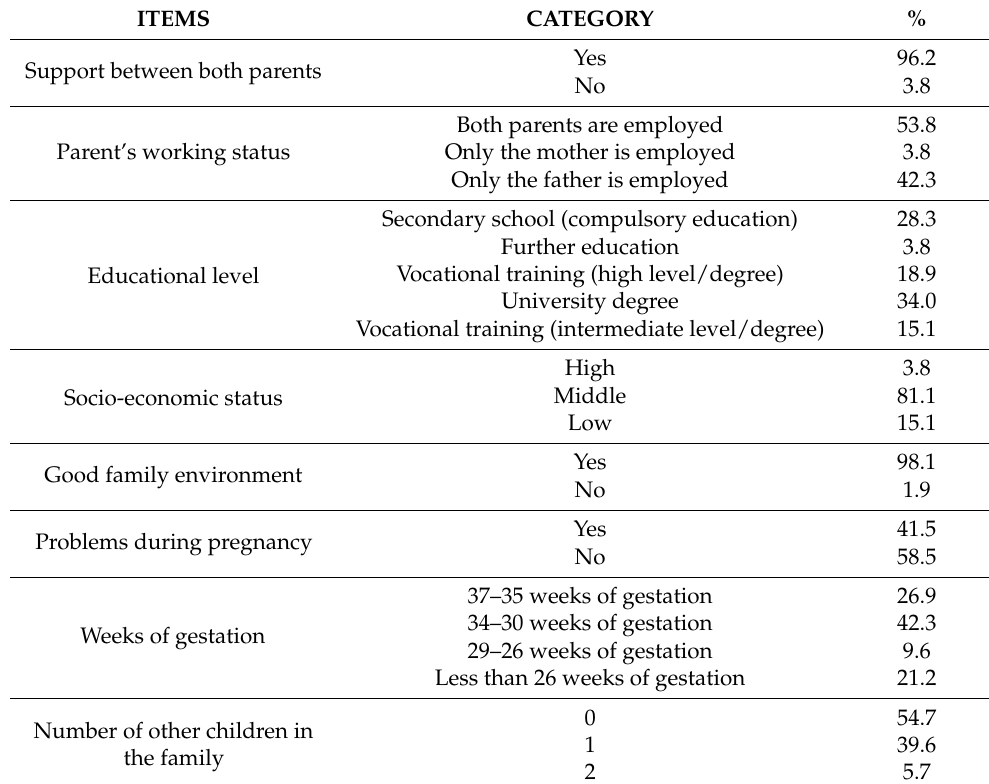
Table 1. Data related to the family